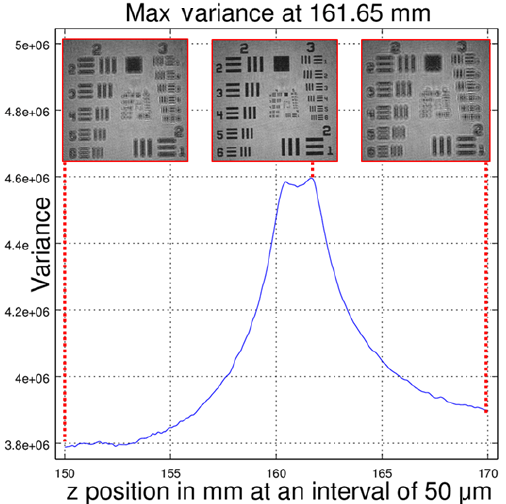
Figure 3. The variance plot of the hologram reconstruction in Fig. 2 at different planes in the z